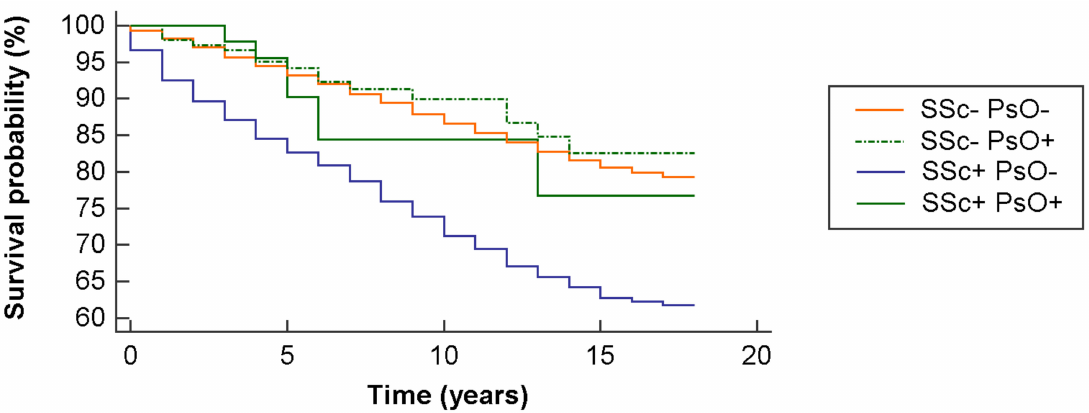
Figure 2. Survival probability according to the Kaplan-Meier analysis, stratified based on the occurrence of systemic sclerosis (SSc) and psoriasis (PsO) diagnosis.